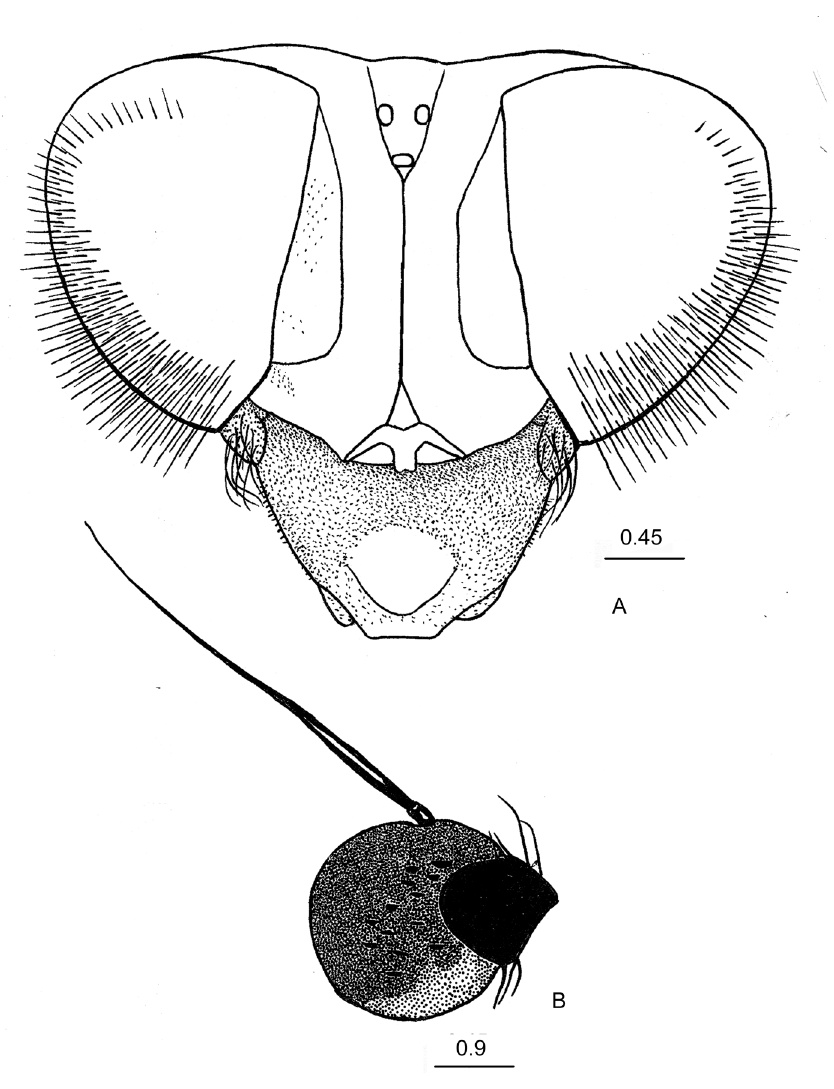
Fig. 47. Cheilosia ( Montanocheila ) pernigra sp. nov., holotype, ♀ (ZSMC). A . Head, dorsal view. B . Pedicel, basoflagellomere and arista, lateral view. Scale bars indicated in